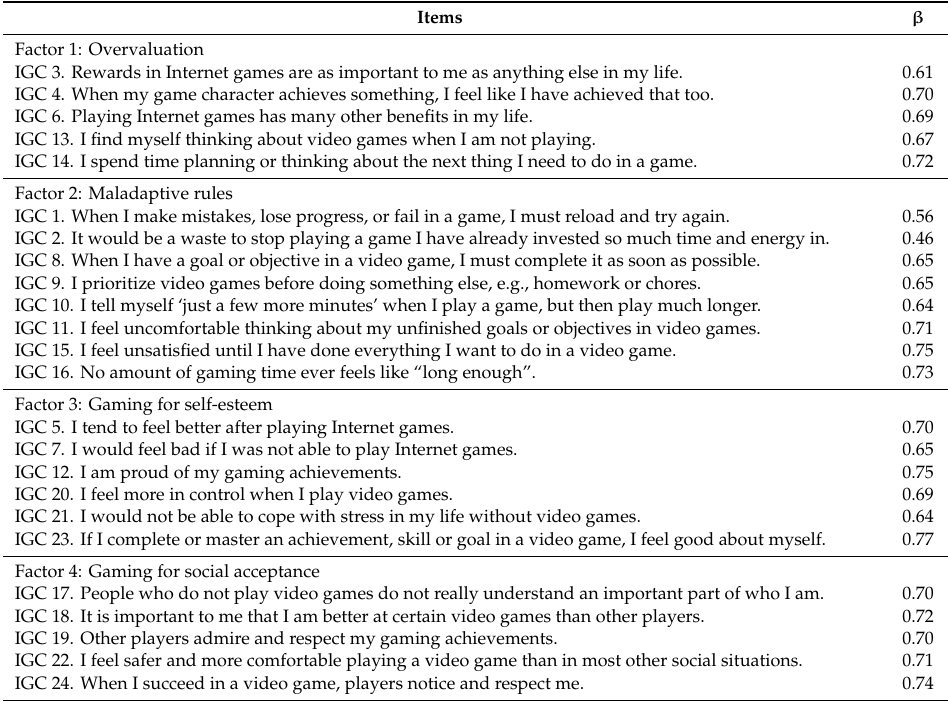
Table 2. Confirmatory factor analysis of the original Internet Gaming Cognition Scale. Items